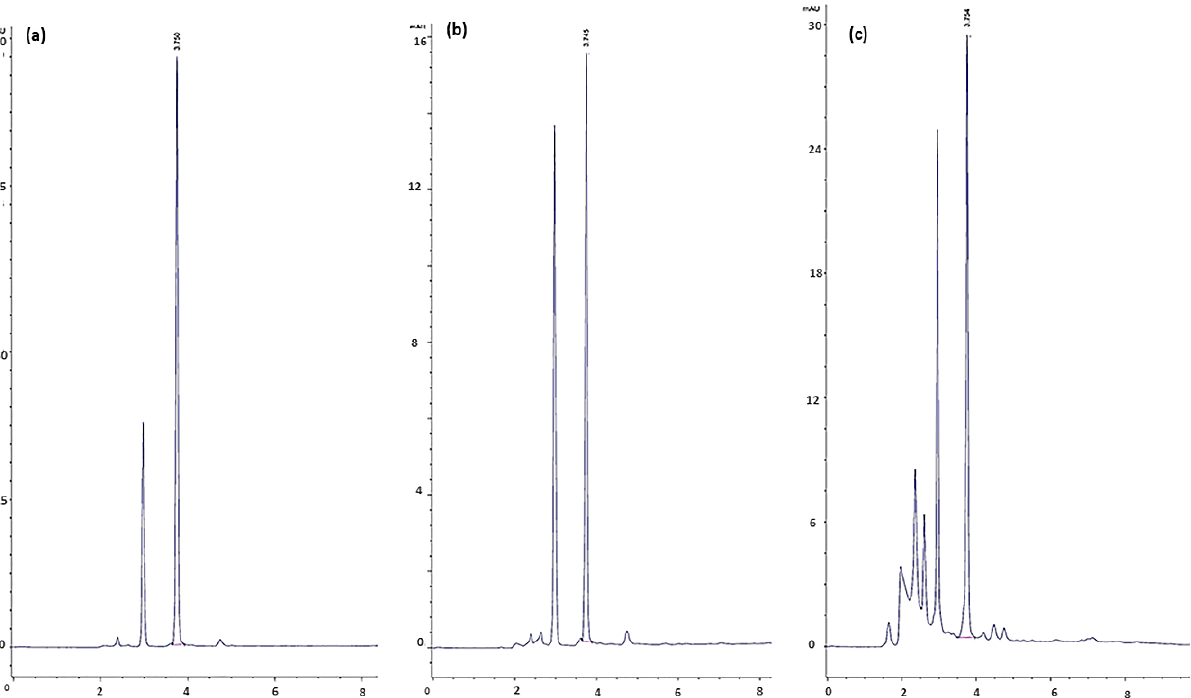
Figure 10. HPLC chromatograms of ( a ) control solution at time 0, ( b ) control solution at time 60 min, and ( c ) postbiotic at time 60 min, determined during anti-tyrosine activity analysis.